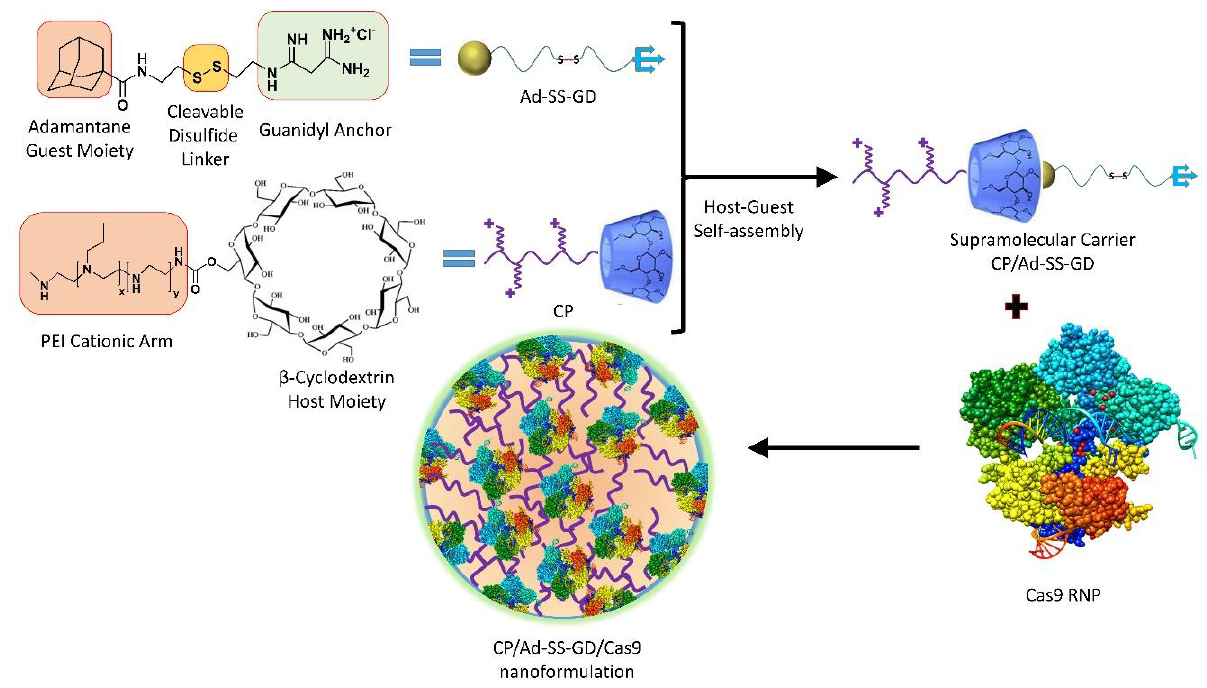
Figure 8. Diagrammatic representation of CP/Ad-SS-GD nanoformulation assembly for intracellular CRISPR/Cas9 delivery induced by GSH.